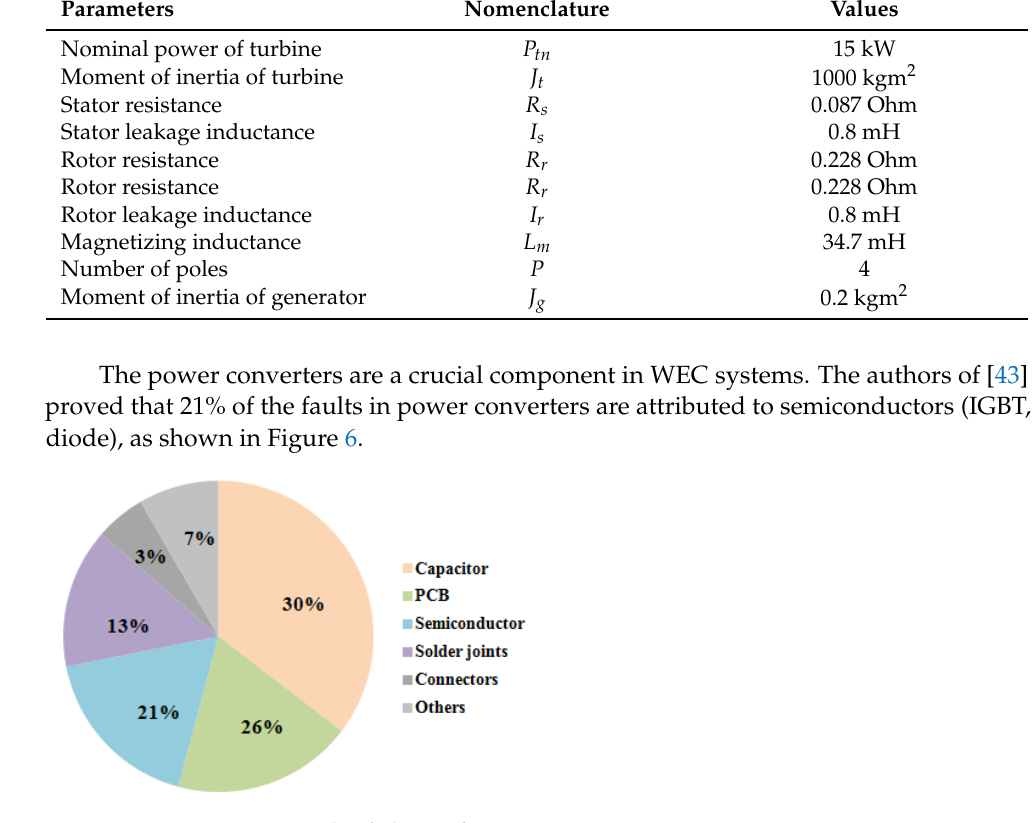
Figure 6. Common catastrophic failures of